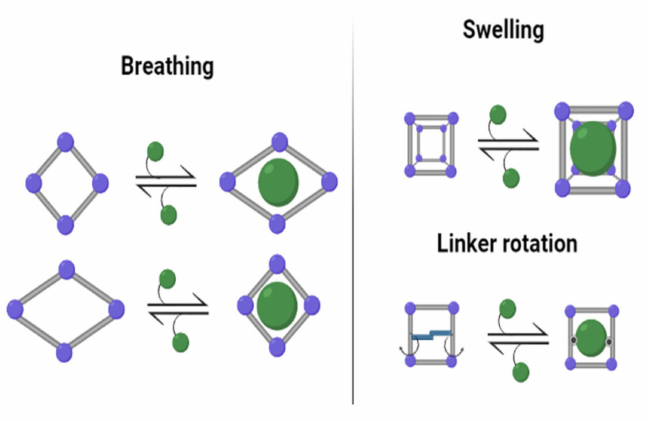
Figure 2. Mechanisms arising from the flexor capacity of MOFs. The green spheres represent the ‘guest’